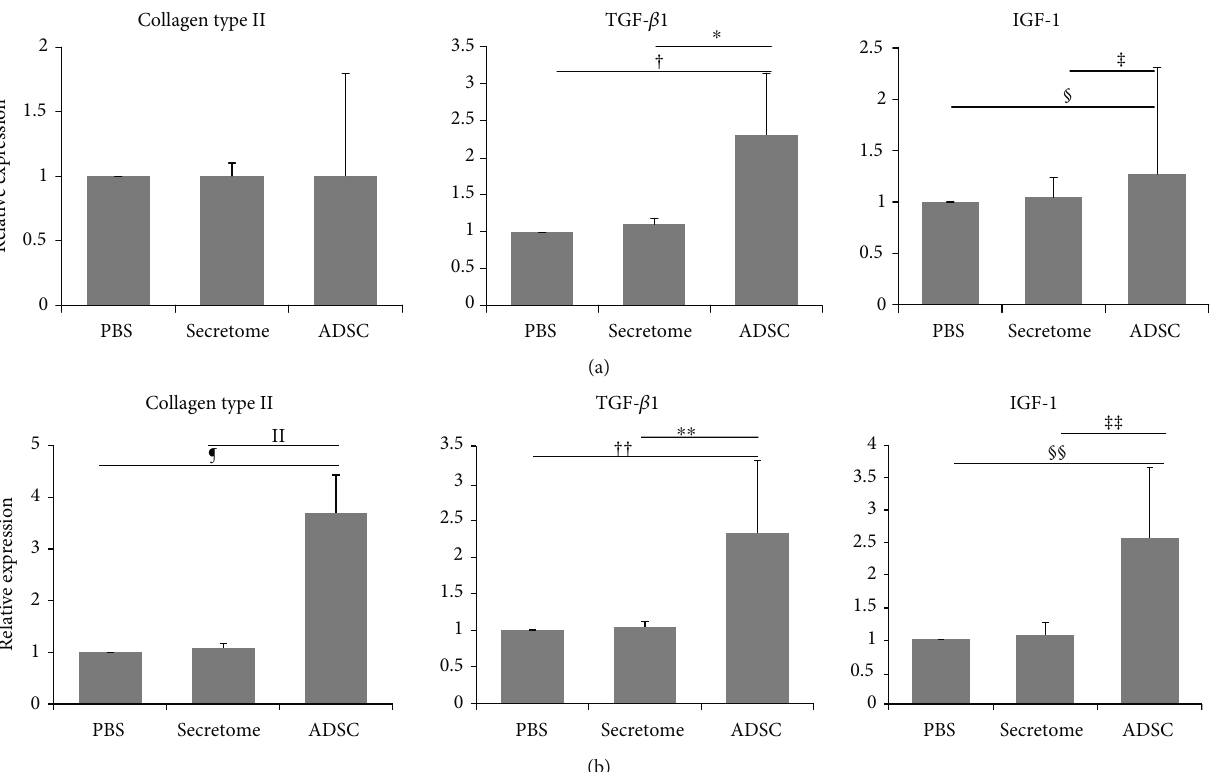
Figure 6: The expression levels of genes encoding collagen type II and various growth factors at 4 (a) and 8 (b) weeks after ADSC injection. The collagen type II expression level was signi fi cantly higher in the ADSC than in the secretome or PBS group 8 weeks after ADSC injection. In the ADSC group, the expression levels of transforming growth factor- (TGF-) β 1 and insulin-like growth factor (IGF) were signi fi cantly higher than in the secretome or PBS group at 4 and 8 weeks postinjection. ∗ , ‡‡ p = 0 : 002 ; † ,§§ p = 0 : 001 ; ‡ p = 0 : 023 ; § p = 0 : 011 ; ǁ ,¶, ∗∗ , †† p < 0 : 001 . ADSCs: adipose-derived stromal cells; PBS: phosphate-bu ff ered